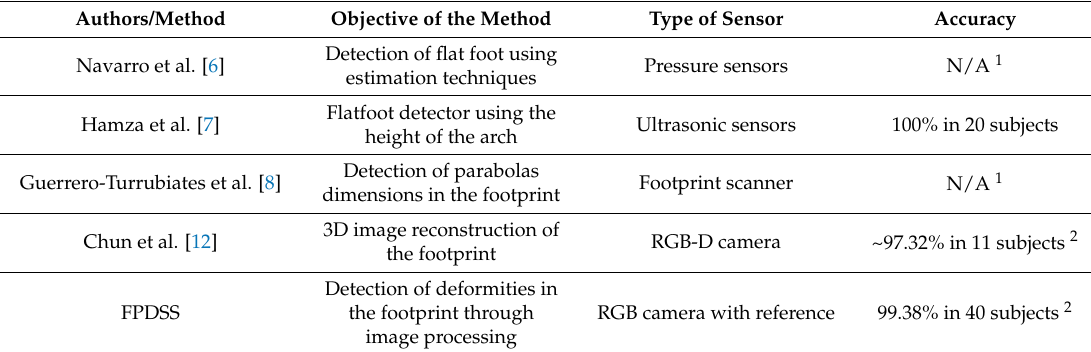
Table 1. Comparison of the methods used by different sensors to diagnose foot deformities.